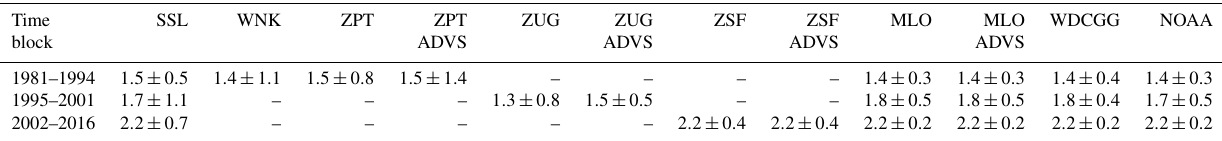
Figure 5. Mean diurnal plots at ZSF during 2016 by day of the week for (a) CO and (b) NO, and (c) the standardized daily passenger number at the Zugspitzplatt and Zugspitze summit combined. Table 2. Mean annual CO 2 growth rates in ppmyr − 1 at the 95% confidence interval based on three time blocks for all measurement sites/locations studied (SSL – Schauinsland; WNK – Mount Wank; ZPT – pedestrian tunnel at Mount Zugspitze; ZUG – Zugspitze summit; ZSF – Zugspitze Schneefernerhaus; MLO – Mauna Loa; WDCGG and NOAA – global means). ADVS means the data were selected using the ADVS method. This comparison refers to data from all years including the corresponding time period for all stations. Measurement sites or locations where data are not available for calculating the corresponding time blocks are shown by “–”.